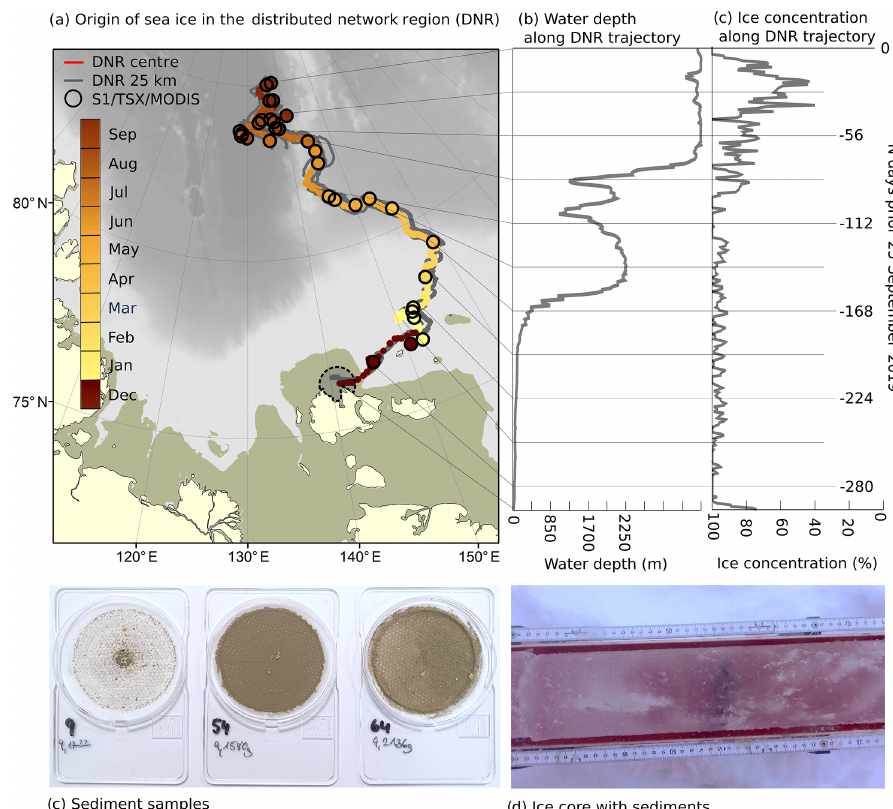
Figure 4. (a) Lagrangian backward trajectories (see Methods) of the DNR. The multicoloured trajectory line, with colour corresponding to the month of year, indicates the centre of the DNR (Central Observatory). The dashed circle provides the confidence bound of the ice origin. The grey lines provide additional trajectories for four points in the DNR at a distance of 25km. Derived trajectories were verified by a manual tracking of the Central Observatory based on Sentinel-1, TerraSAR-X and MODIS (multicoloured circles). The bathymetry is shown in the background. Brownish zones near the coast indicate shallow-water areas of less then 30m water depth. Panels (b) and (c) show water depth (m) and ice concentration (%) along the trajectory of the Central Observatory. (c) Sediment samples obtained from 10cm ice core sections at L1 (left: level ice, 20–30cm depth), L2 (middle: ridged/rafted ice, 243–253cm depth, processed depth accounting for gaps in the core) and the central floe (right: ridged/rafted area at 49–59cm depth). (d) Ice core taken at the central floe ( c , right) with a sediment